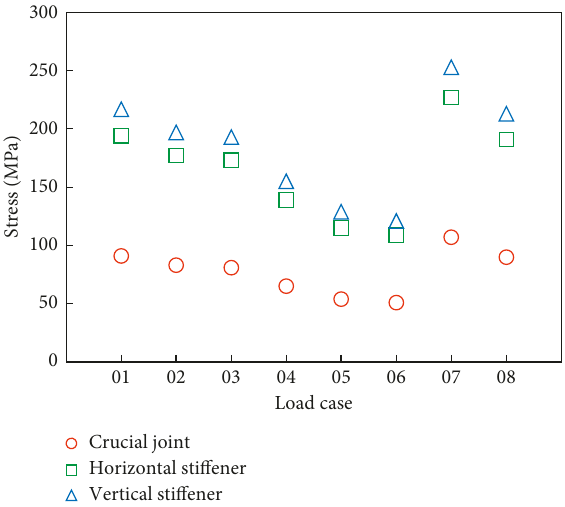
Figure 13: Comparison of the stress ratio for each load